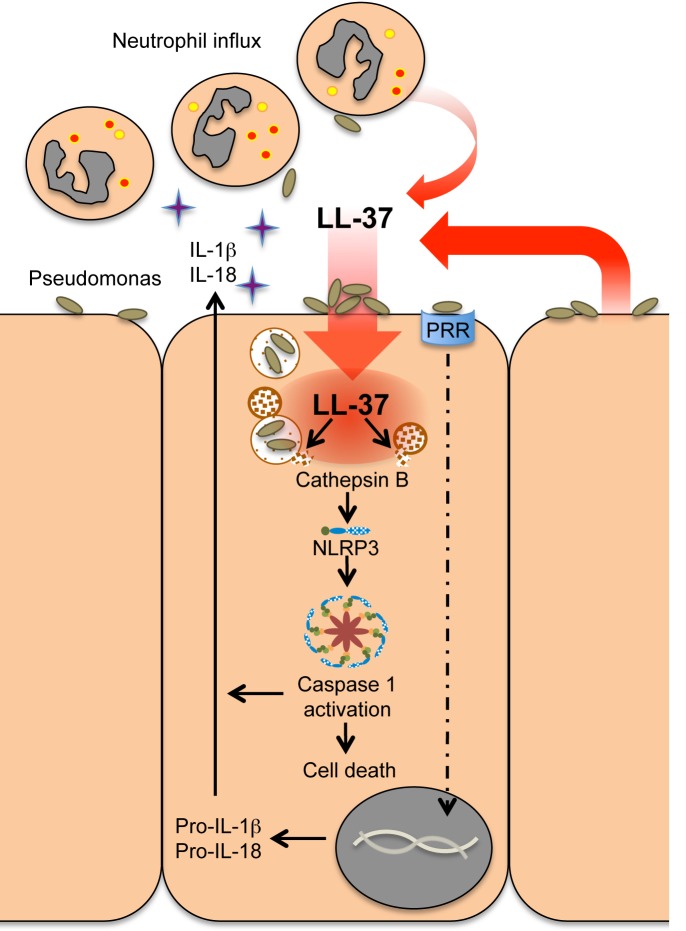
Schematic representation of the mechanism of LL-37-mediated inflammasome activation in Pseudomonas infected airway epithelial cells.Bacterial attachment and internalization into epithelial cells concentrates LL-37 peptide (released by activated cells) into these compromised, infected epithelial cells. Entry of bacteria and cathelicidin into the cell triggers activation of the NLRP3 inflammasome via induction of lysosomal leakage and the release of cathepsin B. Caspase 1 activation in these cells facilitates release of pro-inflammatory cytokines IL-1β and IL-18, promotes recruitment of neutrophils to the affected area, enhances protective inflammation, and may lead to altruistic cell death of the infected cell.